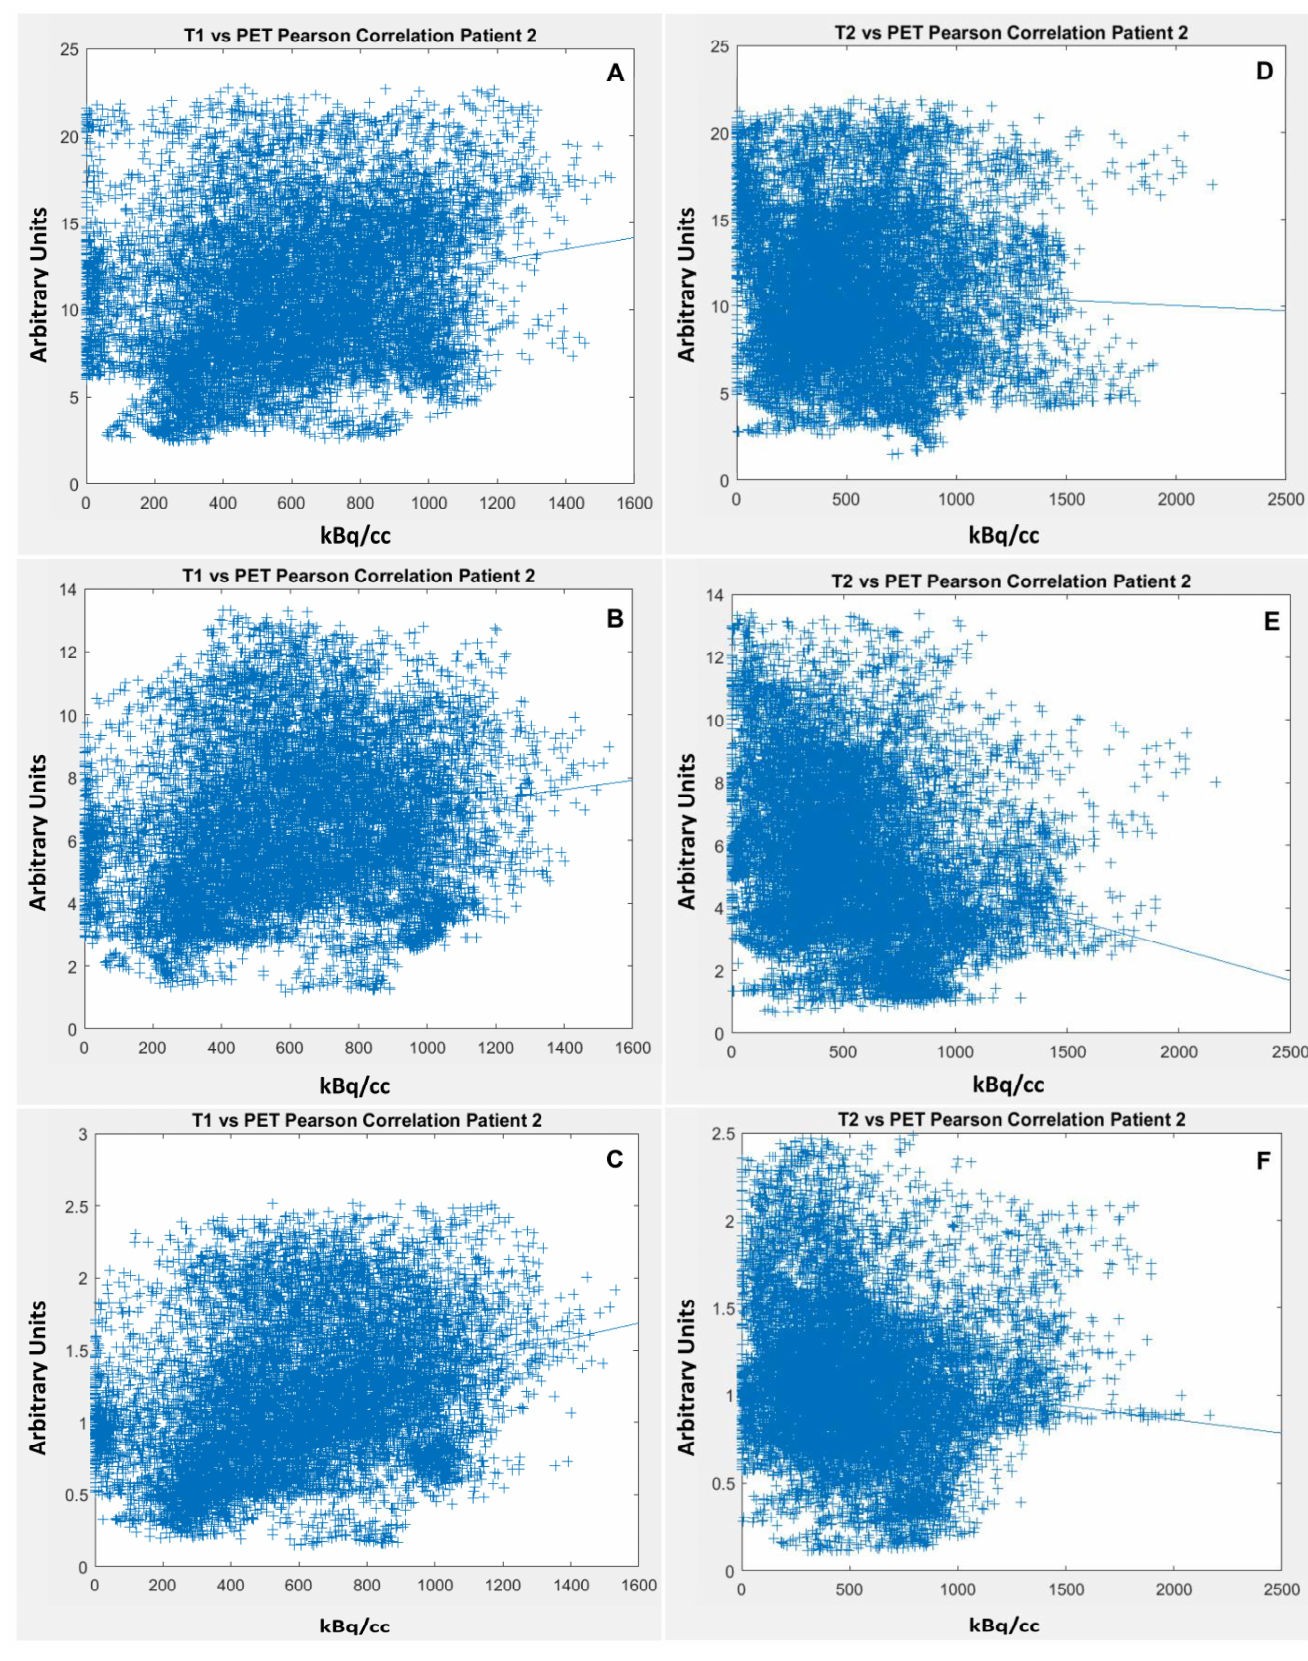
Figure 3. Patient number 2: Left column ( A – C ): correlation of ceT1w vs. 68 Ga-FAPI PET at 10, 60 and 180 min. Right column ( D – F ): correlation of T2w vs. PET/CT at 10, 60 and 180 min.